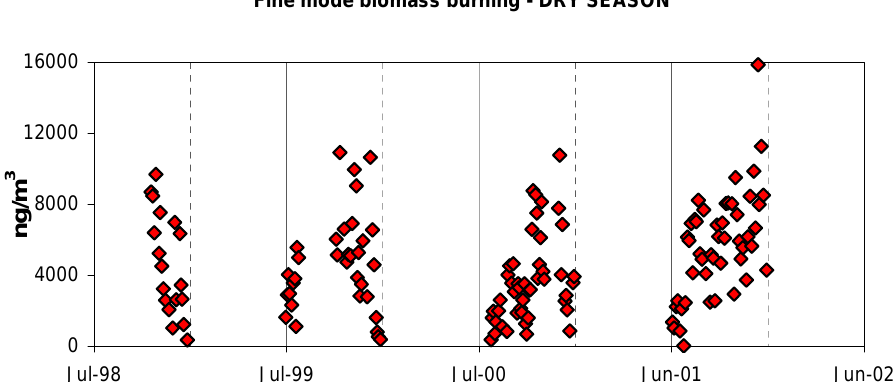
Fig. 11. Absolute concentration of aerosols in the fine mode for each sample, obtained by the APCA technique. Each plot in the figure represents the absolute mass contribution of the identified sources of aerosols: (a) Biogenic contribution, separated in absorbing and non- absorbing components, (b) Soil dust and (c) Biomass burning (Jul–Dec